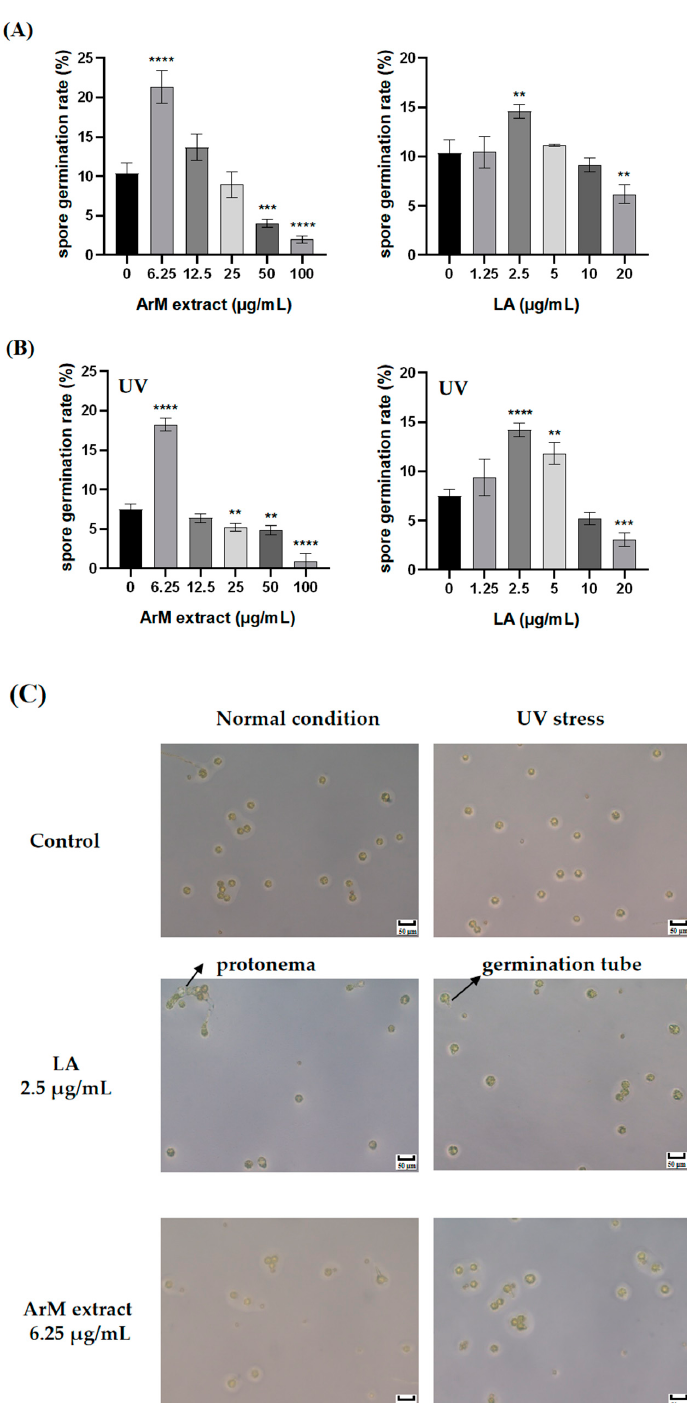
Figure 6. The effect of LA and extraction of ArM on spore germination under normal conditions and UV stress. ( A ) The spore germination rate of M. polymorpha treated with different concentrations of LA and ArM extract under normal conditions. ( B ) The spore germination rate of M. polymorpha treated with different concentrations of LA and ArM extract under UV stress. ( C ) Spore morphology of M. polymorpha treated with LA and ArM extract at the maximum promoting concentration under normal conditions and UV stress. Germination rates are expressed as means with the standard deviations. Three groups were set for each concentration, and the number of spores in each group was more than 50. Analysis of variance (ANOVA) and multiple range test (Tukey’s test) indicated significant differences. ** p < 0.01, *** p < 0.001, **** p <